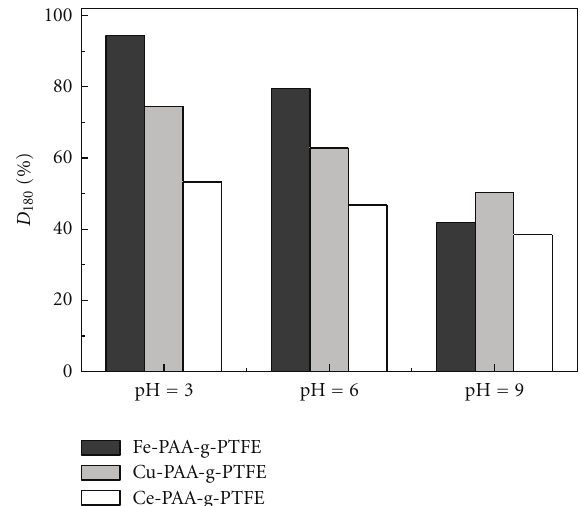
Figure 8: Dye degradation at di ff erent pH levels for three